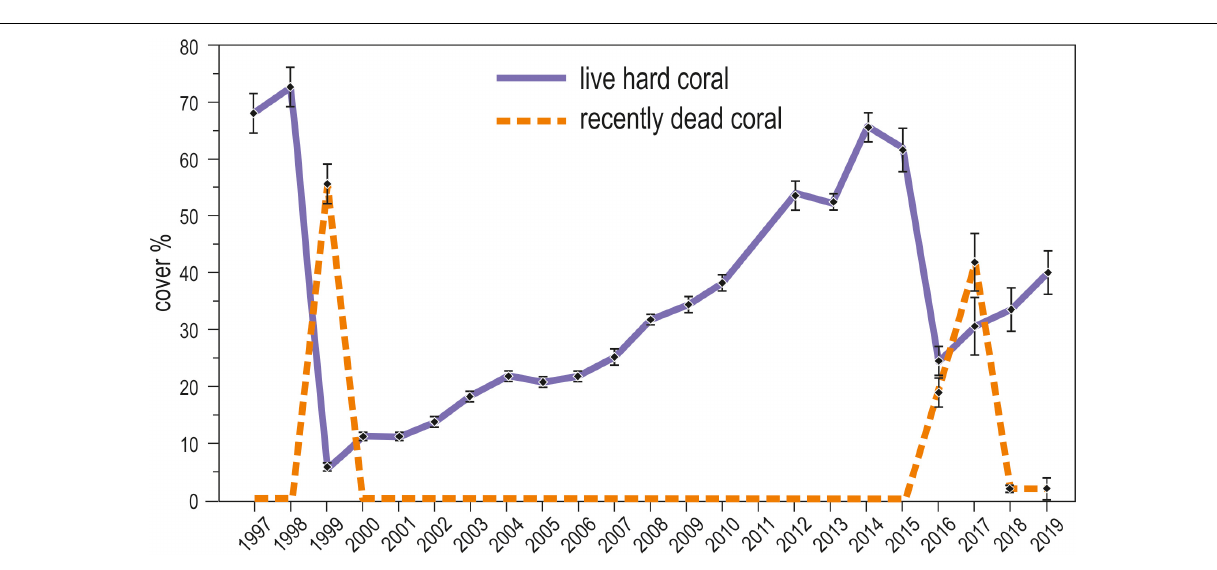
FIGURE 3 | Twenty-three year trends (1997–2019) of the mean ( ± standard error) percent cover of live hard coral (violet solid line) and recently dead coral (orange dashed line) in shallow reefs (about 5 m depth) of the Maldives.